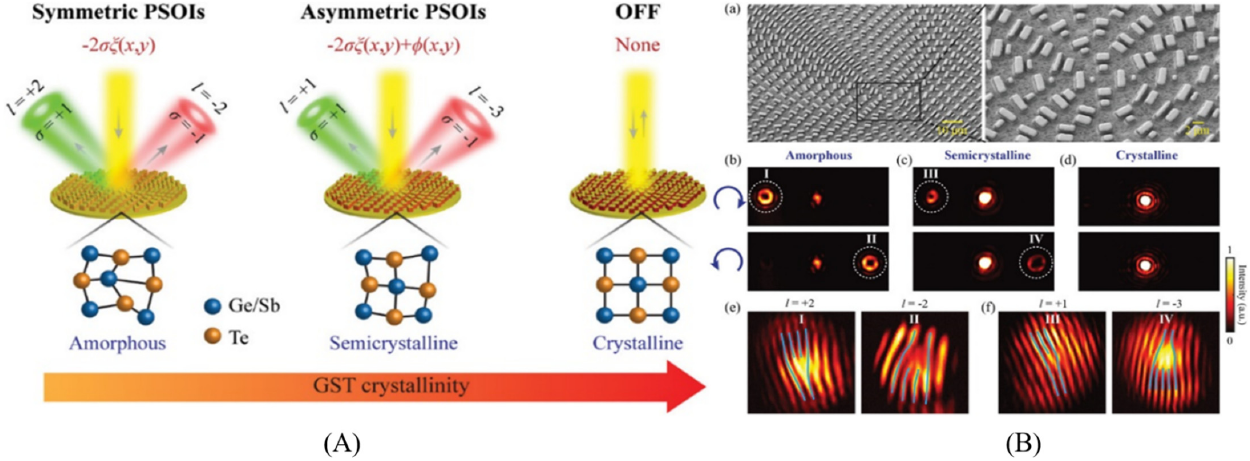
Figure 11. ( A ). The active SAM-to-OAM schematic conversion schematic activated with the suggested metasurface phase change. The crystallization level of GST can be changed among these three modes. ( B ). ( a ) The fabricated converter’s SEM images. ( b – d ) Diffraction patterns under RCP (top) and LCP (bottom) illuminating at various crystallization stages. ( e , f ) Interference patterns generated by interference with the OAM beams shown in ( b,c ) and the titled Gaussian beam, which is circularly polarized (Reprinted with permission from John Wiley and Sons and Copyright Clearance Center).